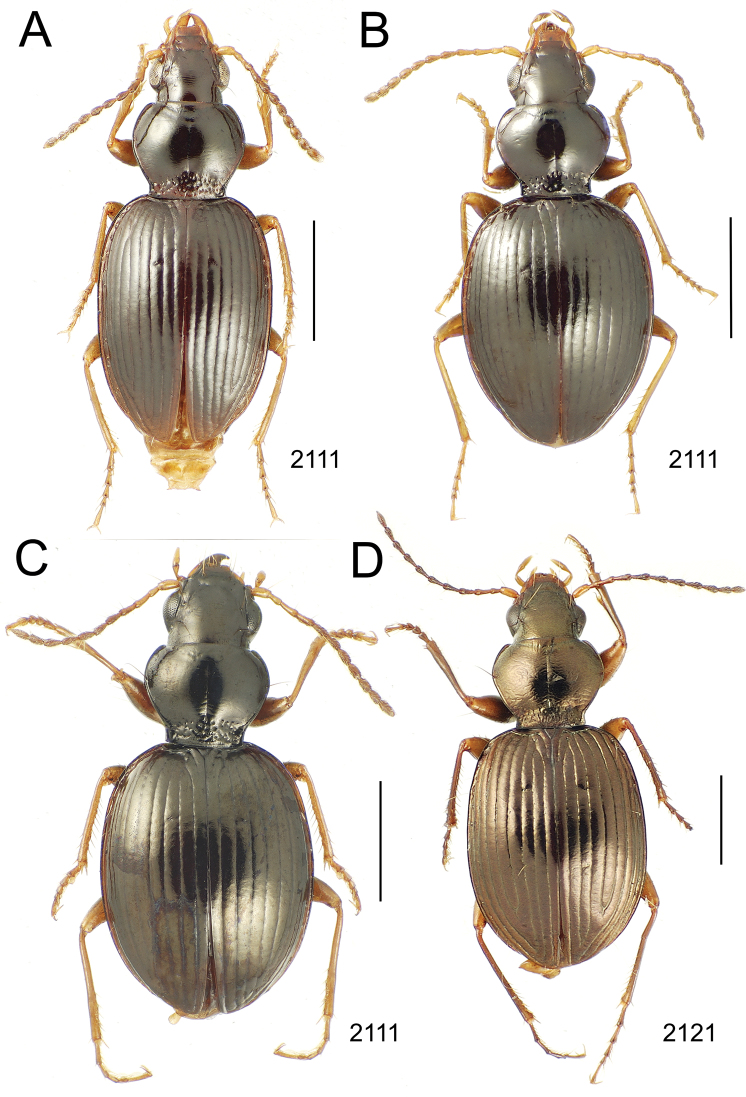
Mecyclothorax spp., dorsal view; scale bars 1.0 mm; setal formula (see Fig. 10) at lower right of each figure A
Mecyclothorax fuscus paratype female (MNHN) B
Mecyclothorax globosus, Marau (setal formula 1111 very rare) C
Mecyclothorax paraglobosus
D
Mecyclothorax cupreus paratype female (MNHN).